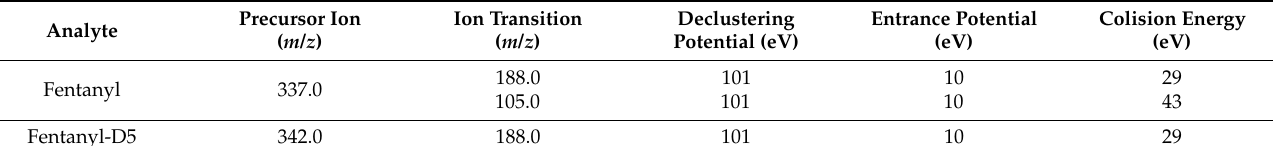
Table 4. The description of parameters used for FEN determination.